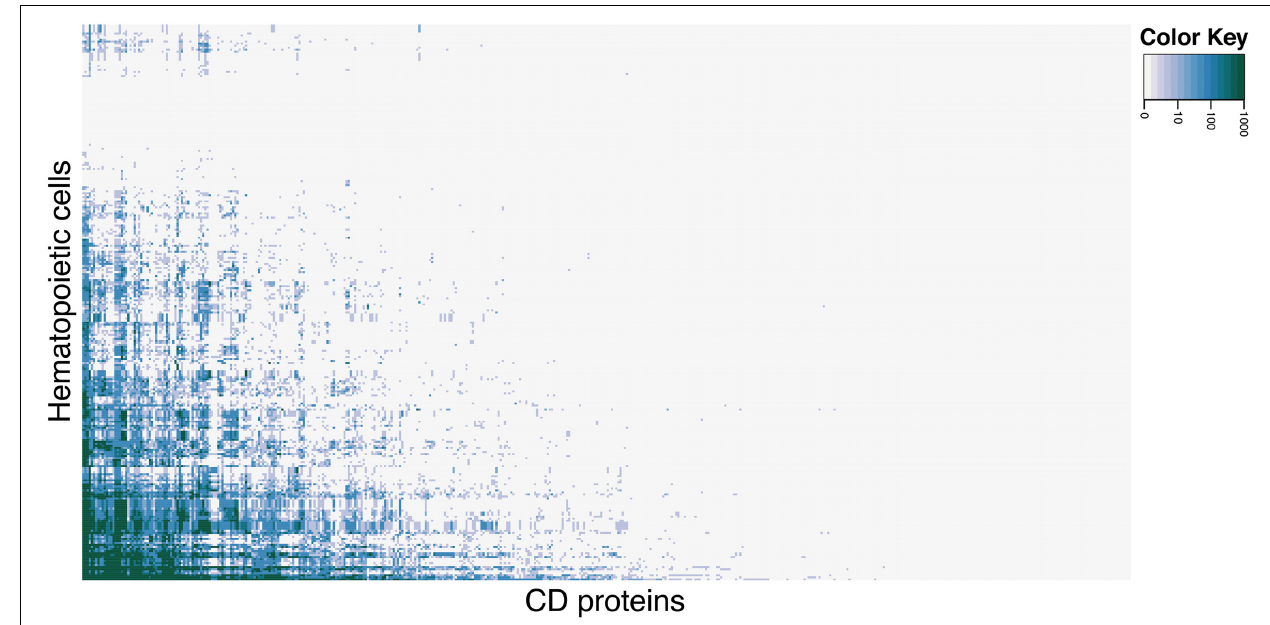
FIGURE 1 | Heat map of CD molecule expression data availability in primary literature. PubMed was queried with combinations of each CD molecule with each hematopoietic cell (including common aliases for both). Light gray cells in the heat map correspond to 0 hits in PubMed